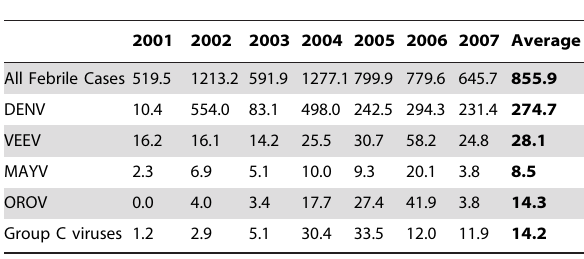
Table 6. Yearly incidence rates of arboviral diseases in Iquitos, Peru, per 100,000